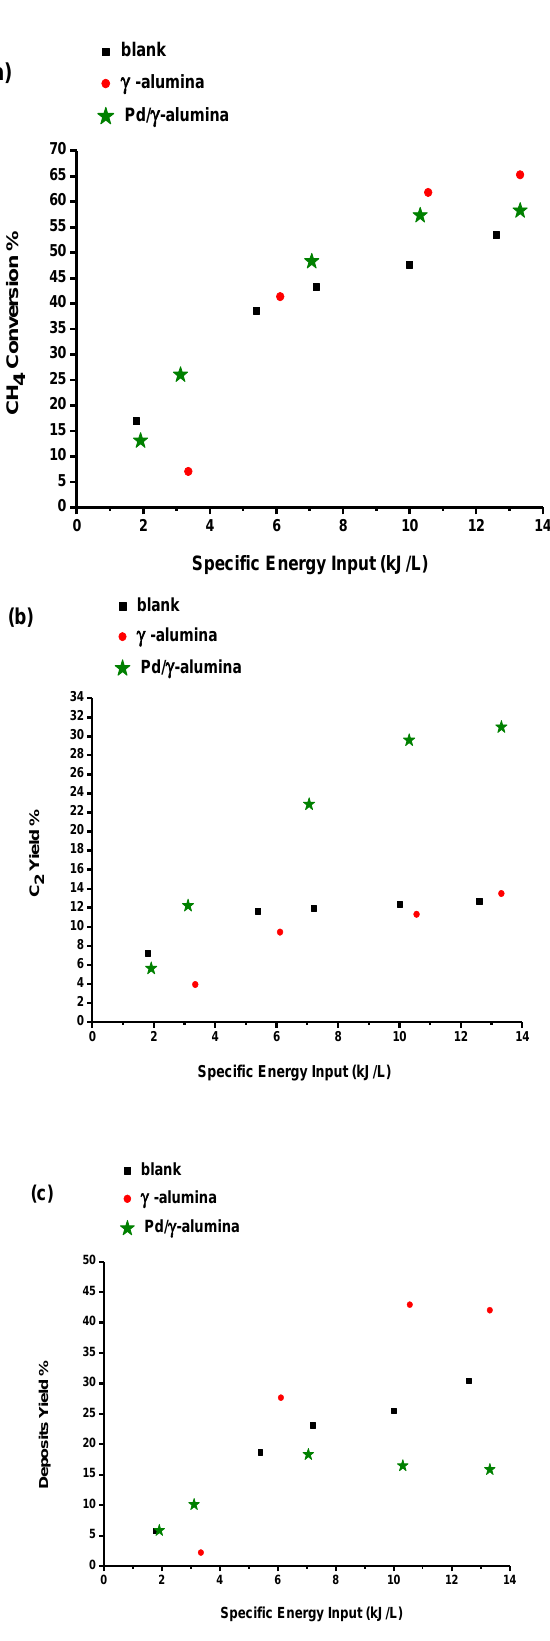
versus specific energy input for the blank reactor and the packed reactor with γ -alumina and 1 wt%